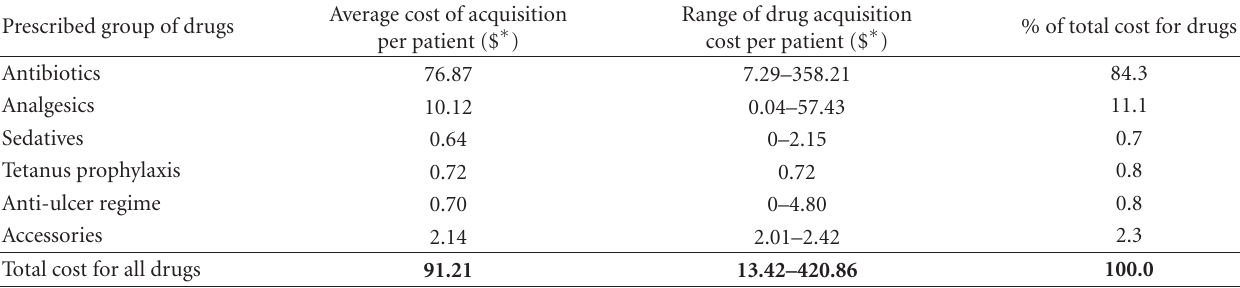
Table 1: Cost of drug use in